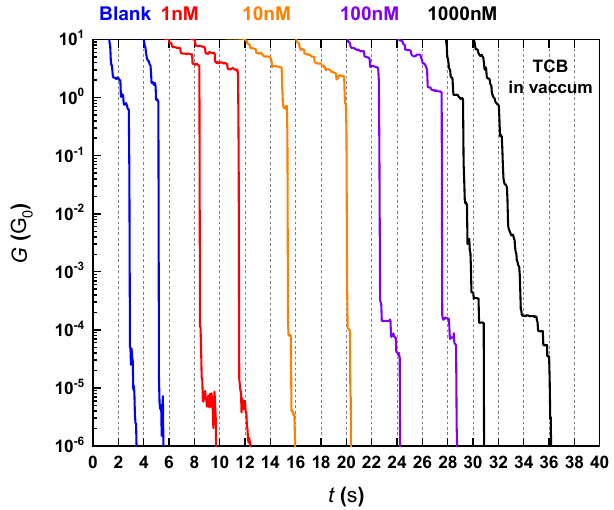
Figure 3. Conductance traces obtained at room temperature in vacuum under various 1,8-octanedithiol (ODT) concentration conditions in 1,2,4-trichlorobenzene (TCB).